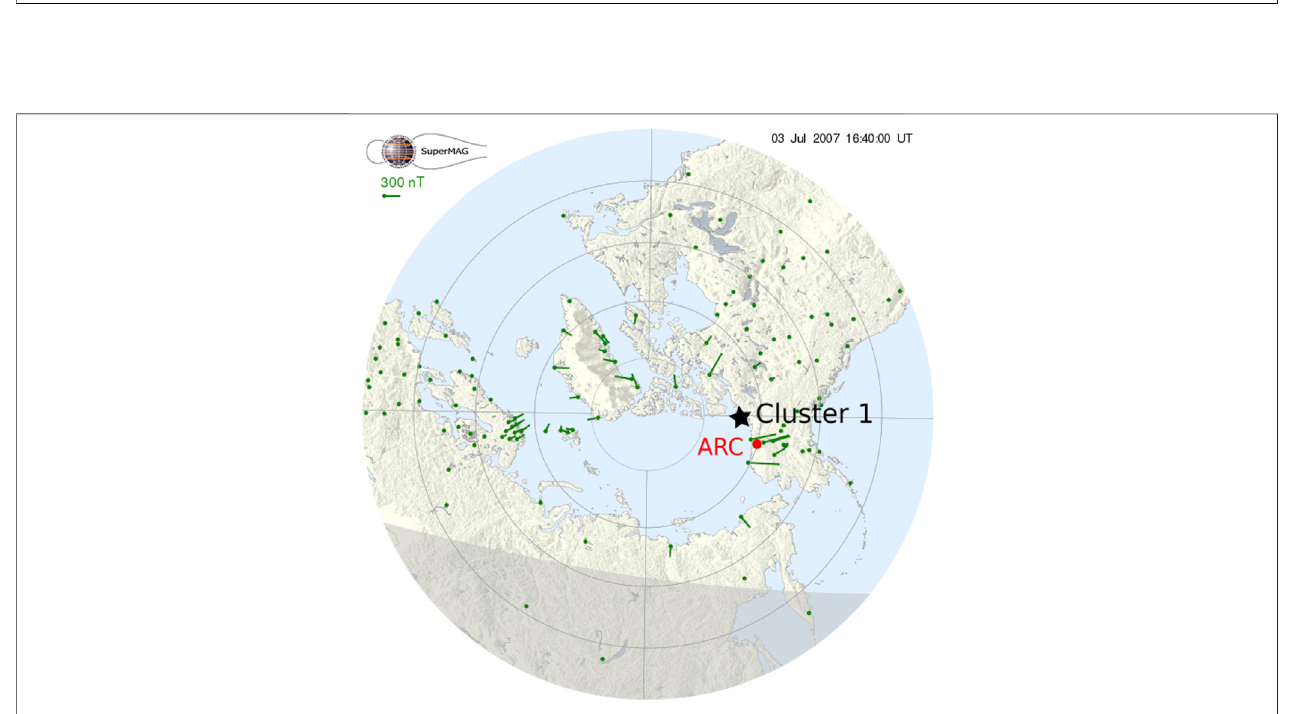
FIGURE 9 | The SuperMAG Polar Plot is shown for July 3, 2007 at 1640 UT. The fi eld line foot point corresponding to Cluster SC 1 is shown by a black star. The green vectors represent the direction and magnitude of ground-based magnetic fi eld disturbances. The approximate location of the Arctic Station (ARC) magnetometer is denoted by the red dot.